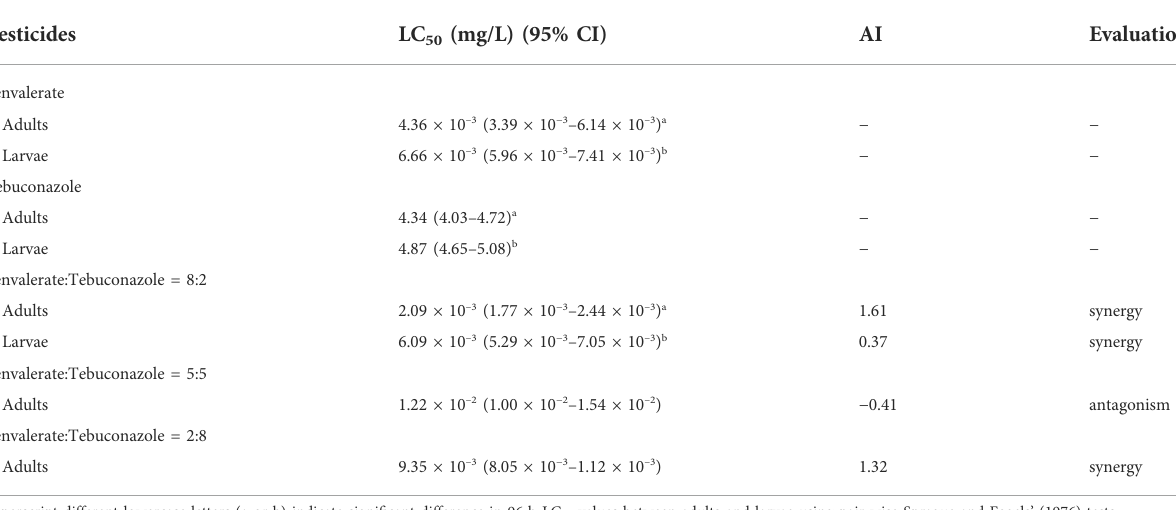
TABLE 3 The acute toxicity of individual and mixed pesticides to zebra fi sh.